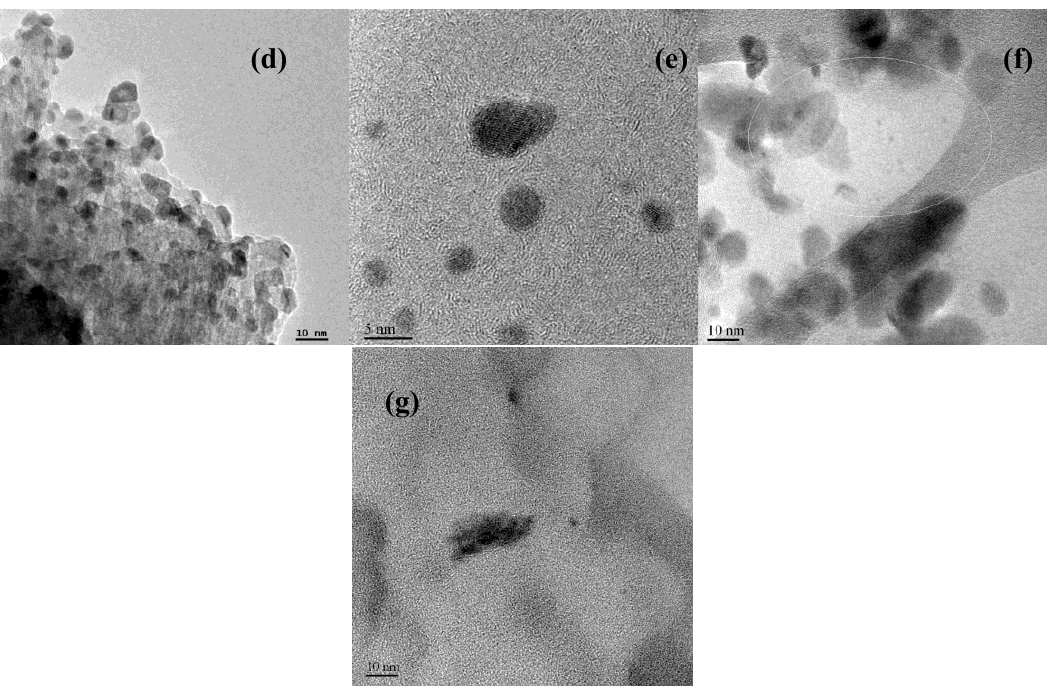
Figure 5. HR-TEM images of the Pd-supported catalysts: ( a ) Pd/Al 2 O 3 ; ( b ) Pd/Ce/Al 2 O 3 ; ( c ) Pd/Fe/Al 2 O 3 ; ( d ) Pd/Mn/Al 2 O 3 ; ( e ) Pd/Ti/Al 2 O 3 ; ( f ) Pd/TiO 2 ; and ( g ) Pd/CeO 2 .